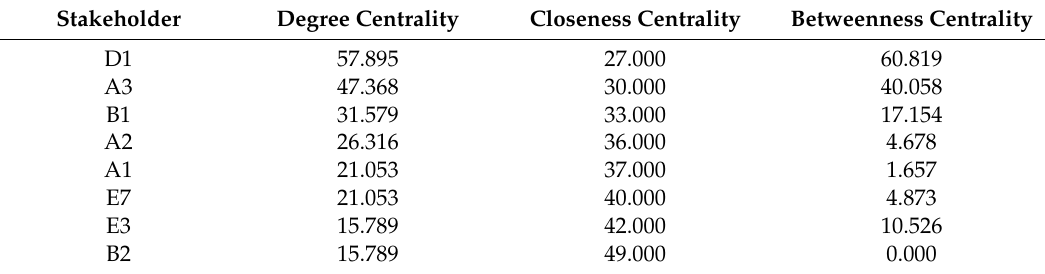
Table 2. The centrality of ERC